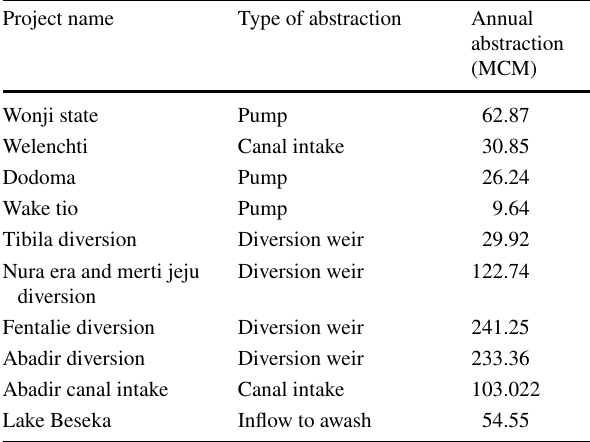
Table 2 Existing and planned